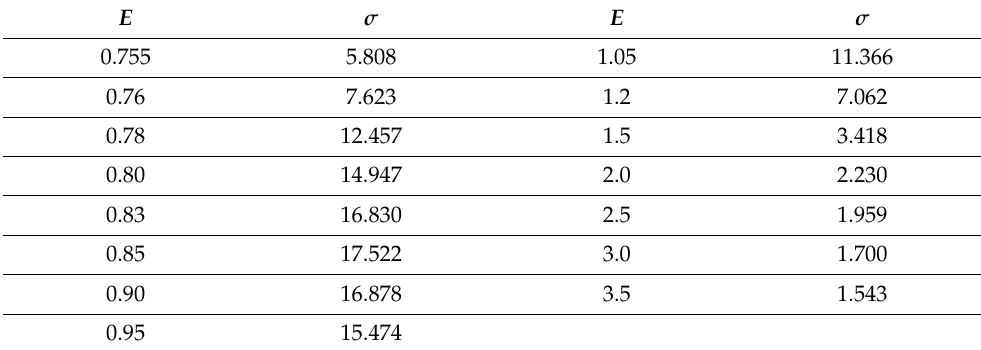
) at various incident energies E (Ry). 0